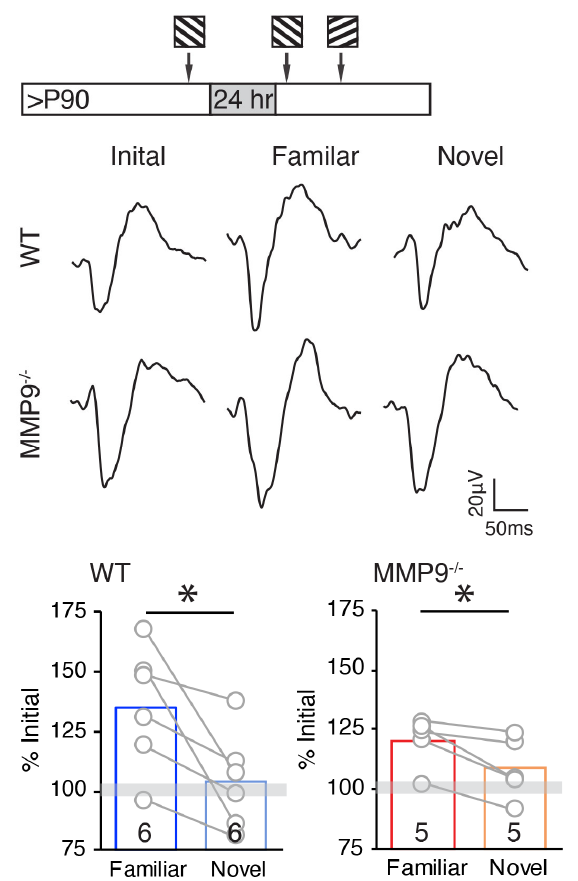
Figure 7. Stimulus ‐ Selective Response Potentiation persists in adult MMP9 − / − mouse V1b. Top: Ex ‐ perimental timeline. Middle: Representative layer 4 VEPs of WT and MMP9 − / − mice in response to the initial 200 presentations of visual stimulation at a single orientation (0.05 cpd 100% contrast gratings reversing at 1 Hz), and a familiar and novel stimuli presented 24 h later. Bottom: Mean VEP amplitudes in WT and MMP9 − / − mice. Grey bar = mean ± SEM of initial VEP; 24 h later, a significant increase in the VEP amplitude is observed in response to the familiar (left) but not novel (right) stimulus orientation, in both WT and MMP9 − / − mice, * p < 0.05, Student’s t ‐ test. n = 6 and 5 subjects for WT and MMP9 − / − , respectively.